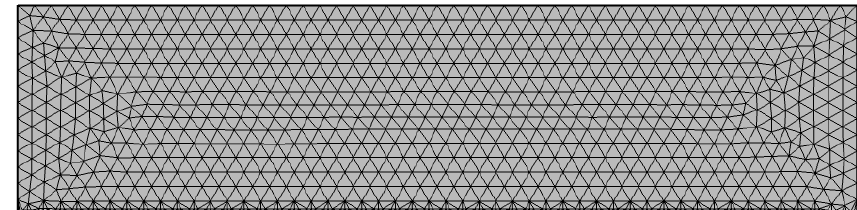
Figure 4. Encrypted FEM model at the slit.